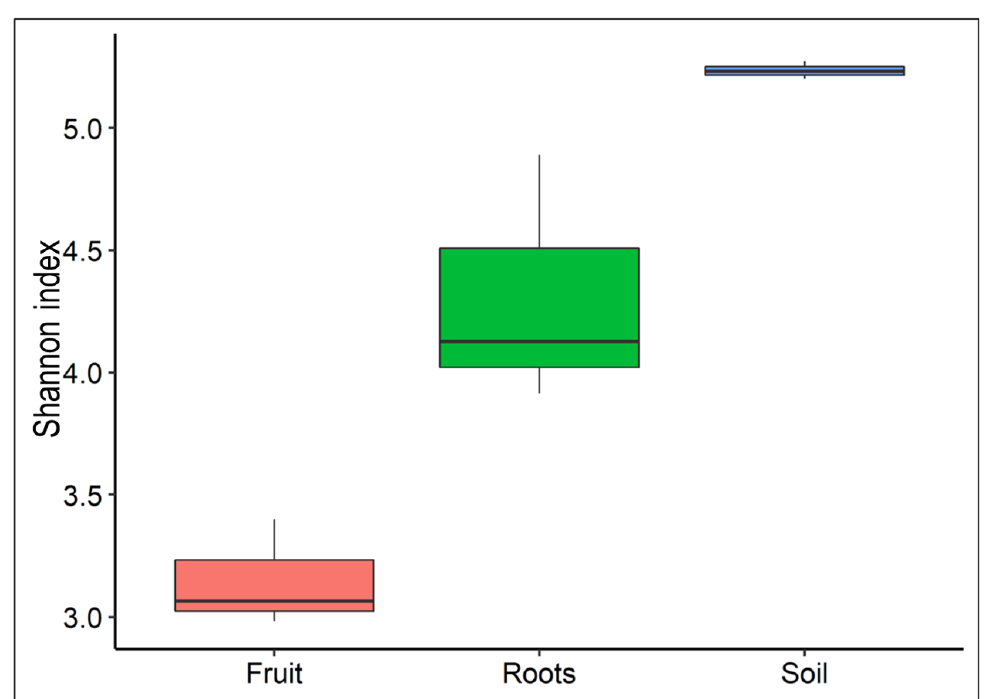
Figure 1. Differences in microbiome diversity of fruit bodies, mycorrhized roots, and rhizosphere. Alpha diversity was based on the Shannon indexes. (Mean values: Fruit: 3.14, Roots: 4.31, and Soil: 5.23).